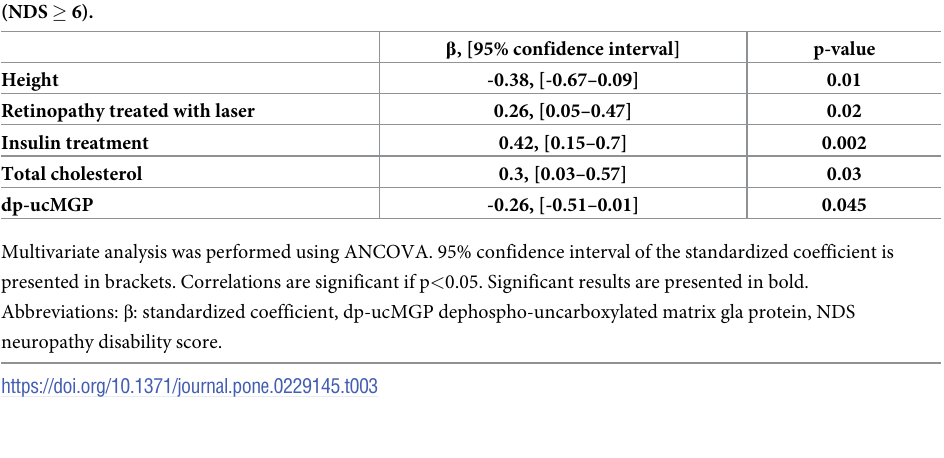
Correlations were performed by Pearson’s coefficient (r). 95% confidence interval of the correlation coefficient was assessed using Fisher’s method, and is presented in brackets. Correlations are significant if p < 0.05. Significant results are presented in bold.